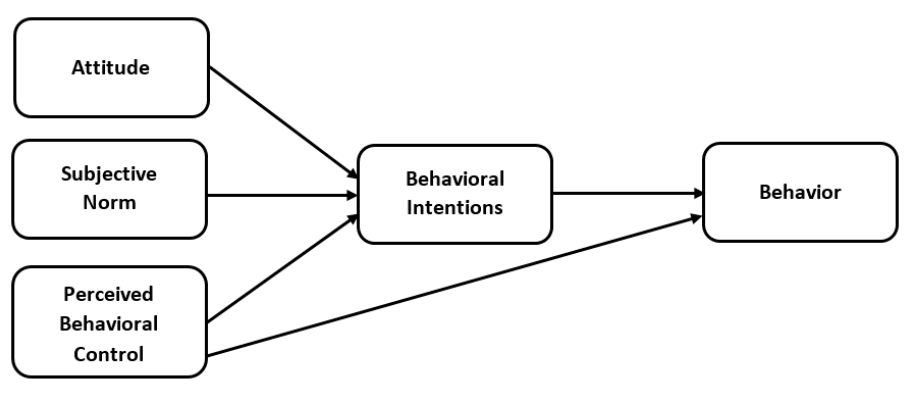
Figure 1: Theory of Planned Behaviour (Ajzen,